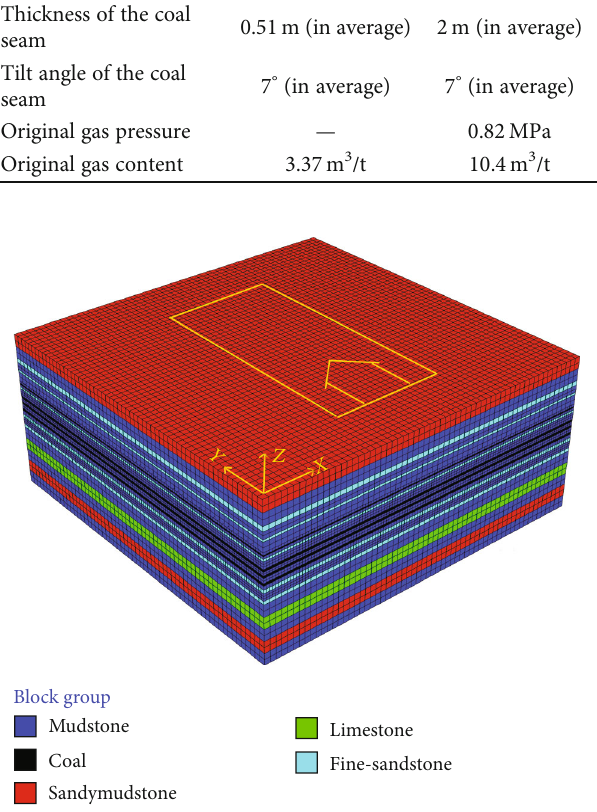
Figure 2: Numerical calculation